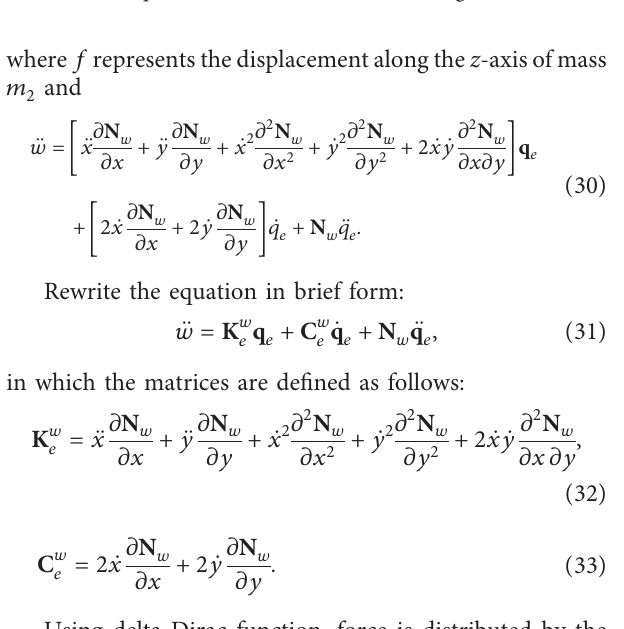
Figure 4: The plate element model under moving oscillator